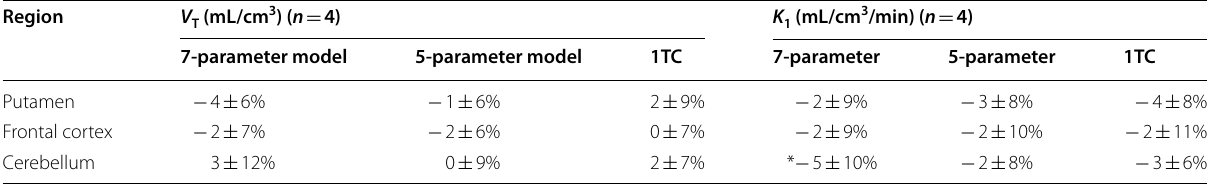
Table 3 Test–retest reproducibility of binding